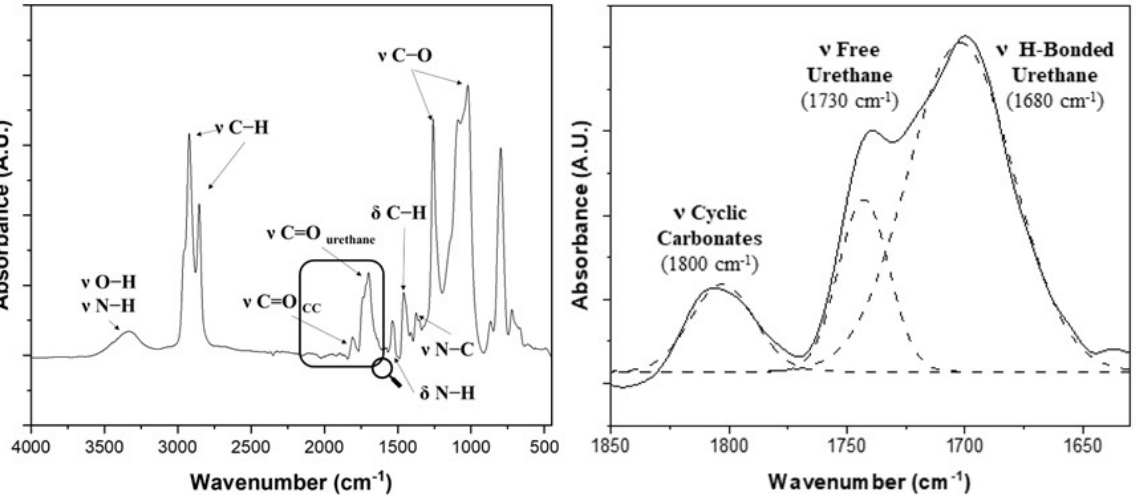
Figure 2. FT-IR NIPU spectra and carbonyl urethane/CC deconvolution (T = 100 ◦ C, A/CC = 1, Figure 2. FT ‐ IR NIPU spectra and carbonyl urethane/CC deconvolution (T = 100 °C, A/CC = 1, t = 30 t = 30 min).